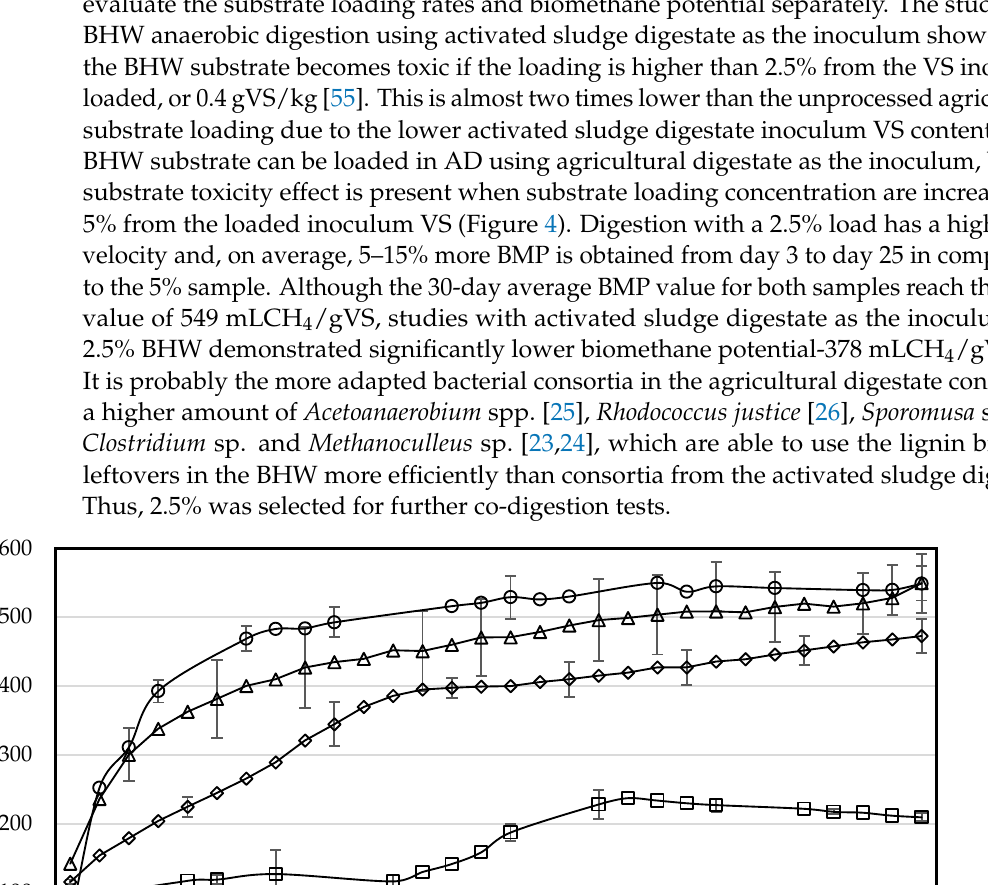
Figure 5. Meat and dairy processing wastewater FOG cumulative biomethane outcome in 30 days with different sludge loads from inoculum VS.